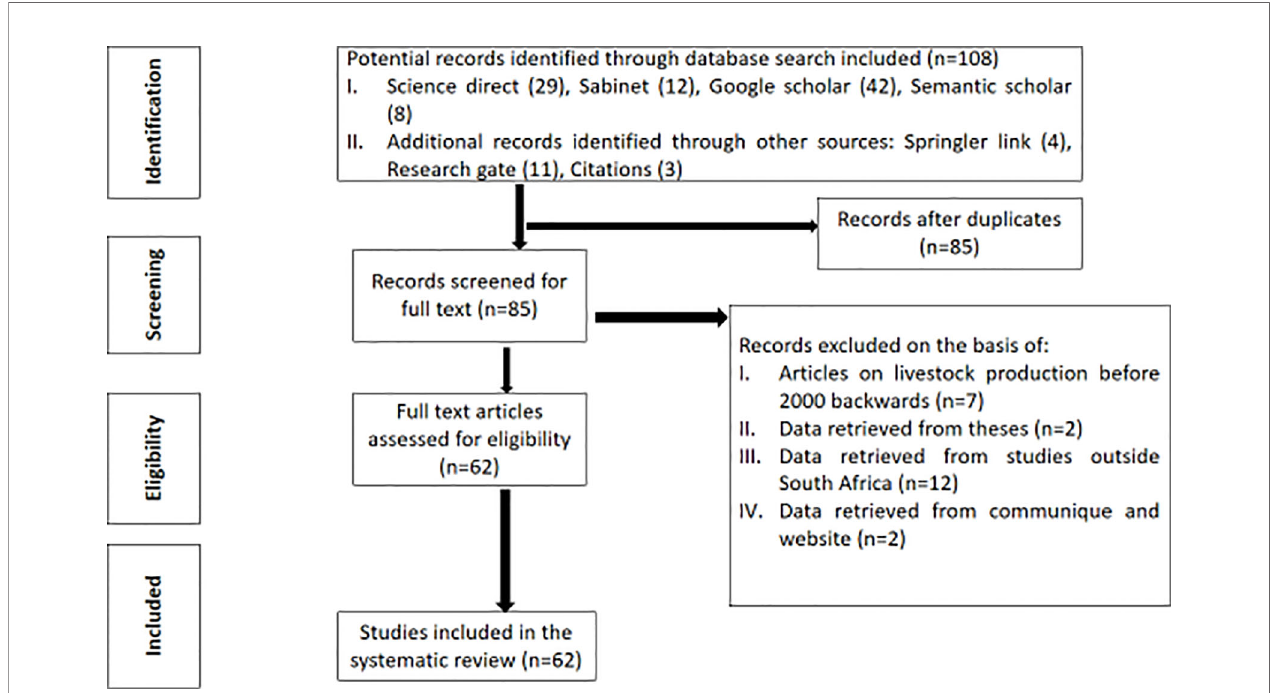
FIGURE 1 | Flow diagram of the screening process of the